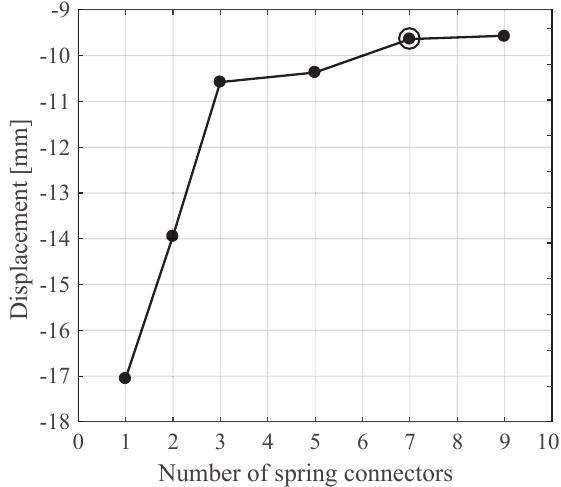
Figure 13. Convergency study for determining the number of spring connector sets. The convergency condition is taken as the variation of the observed maximum vertical displacements (<1% ) obtained under 25 kN load. In addition, 1, 2, 3, 5, 7 and 9 sets of three spring connector types per group representing individual tabs of MTSJ are